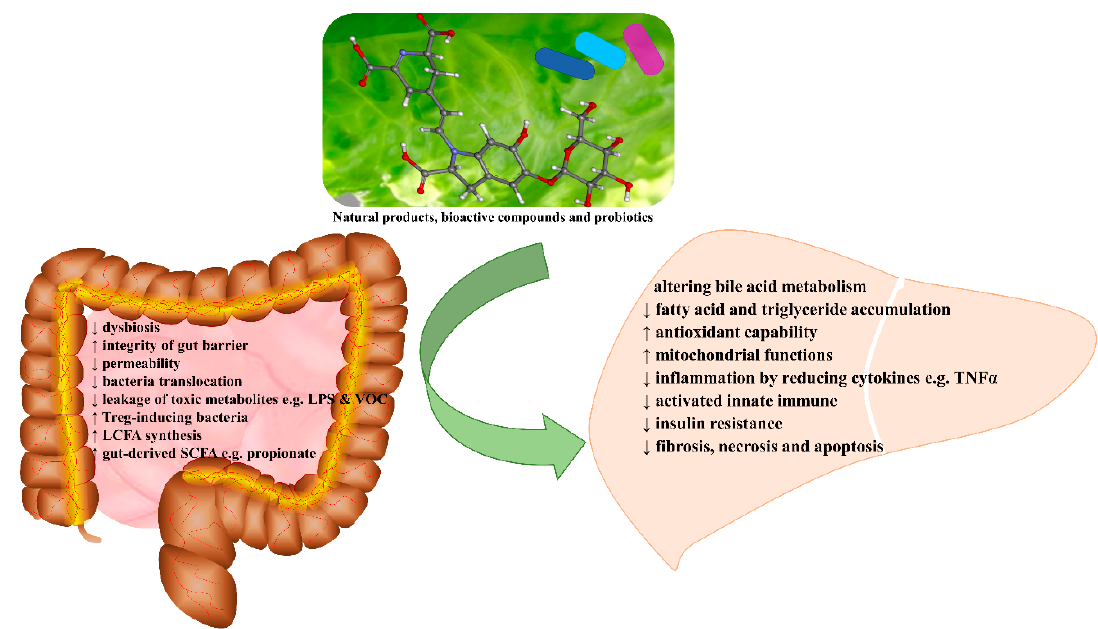
Figure 2. Hepatoprotective effects and mechanisms of natural products via gut microbiota.